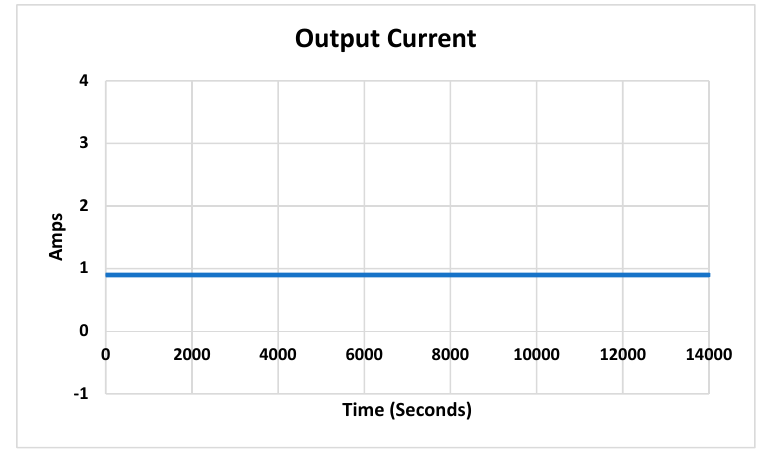
Figure 23. Discharging/Series Branch Voltage.